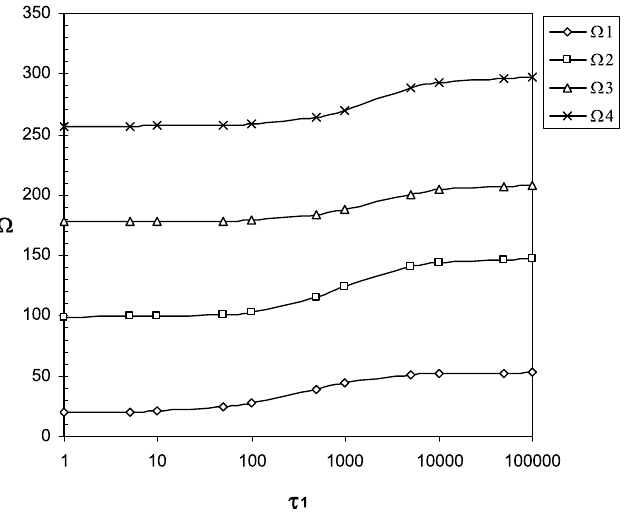
Fig. 4. The fi rst four coupled eigenfrequencies of a SSSS square plate with an elastic point-support ( γ 1 = ∞ ) at its centre ( ξ 1 = η 1 = 0 . 5 ), with respect to the stiffness ratio τ 1